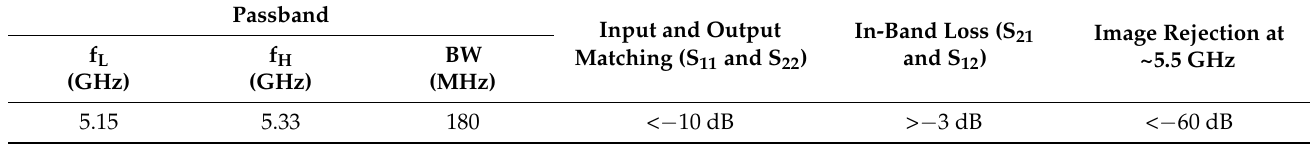
Table 2. The microwave dielectric ceramic filter specifications.